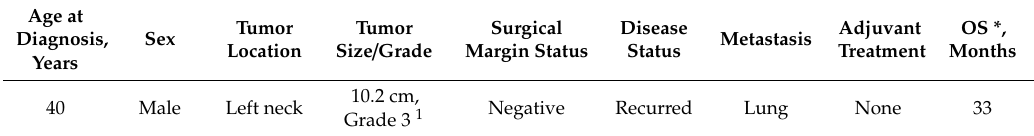
Table 1. Patient Characteristics.